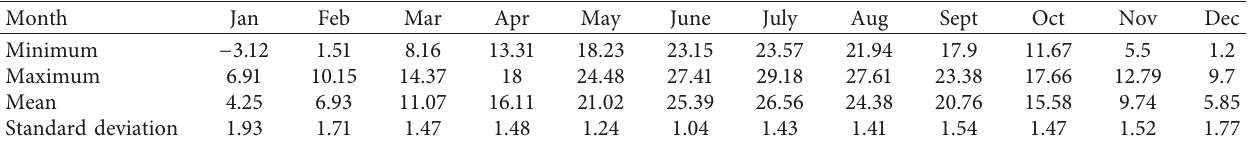
Table 2: Statistical characteristics of monthly temperature (1961–2005).